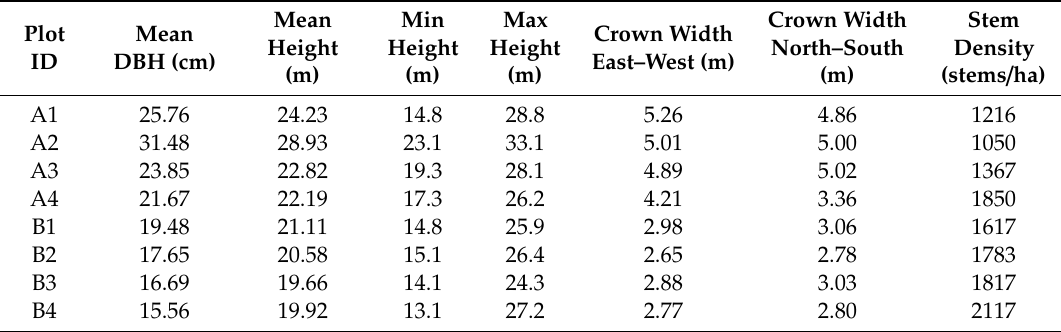
Table 1. Parameters of field plots.